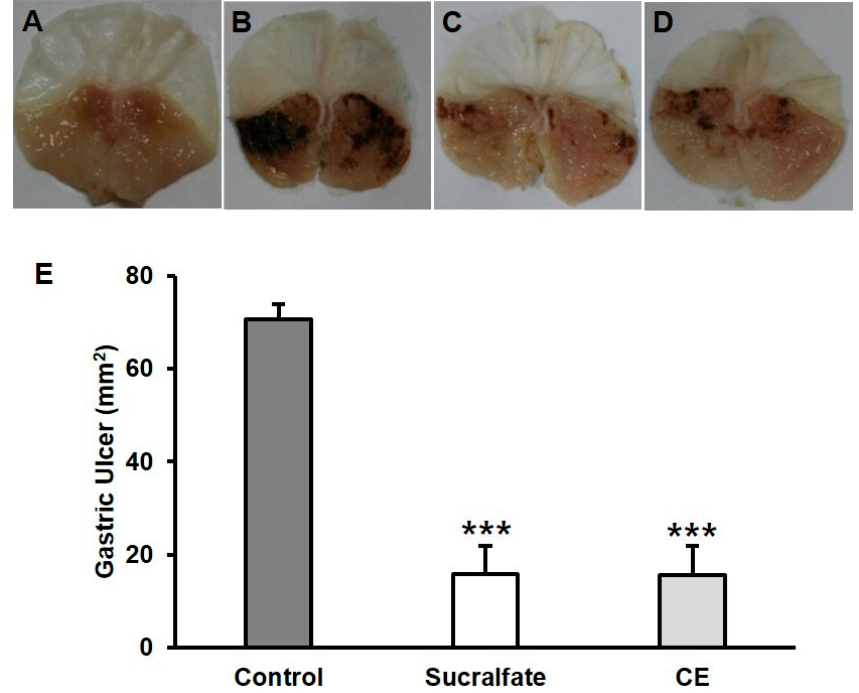
Figure 2. The protective effects of carotenoid extract (CE) from orange-fleshed sweet potato on HCl/ethanol-induced gastric ulcer model in mice. ( A ), normal stomach; ( B ), glandular stomach treated with vehicle; ( C ), the stomach of positive control group treated with sucralfate, 100 mg/kg; ( D ), the stomach of test group treated with CE, 100 mg/kg, p.o., 1 h before administration of 150 mM HCl/ethanol; ( E ) Determination of the gastric ulcer area is expressed in the unit of mm 2 . Data are presented as mean ± standard error of the mean (S.E.M). *** p < 0.001, significantly different from gastric ulcer group ( B